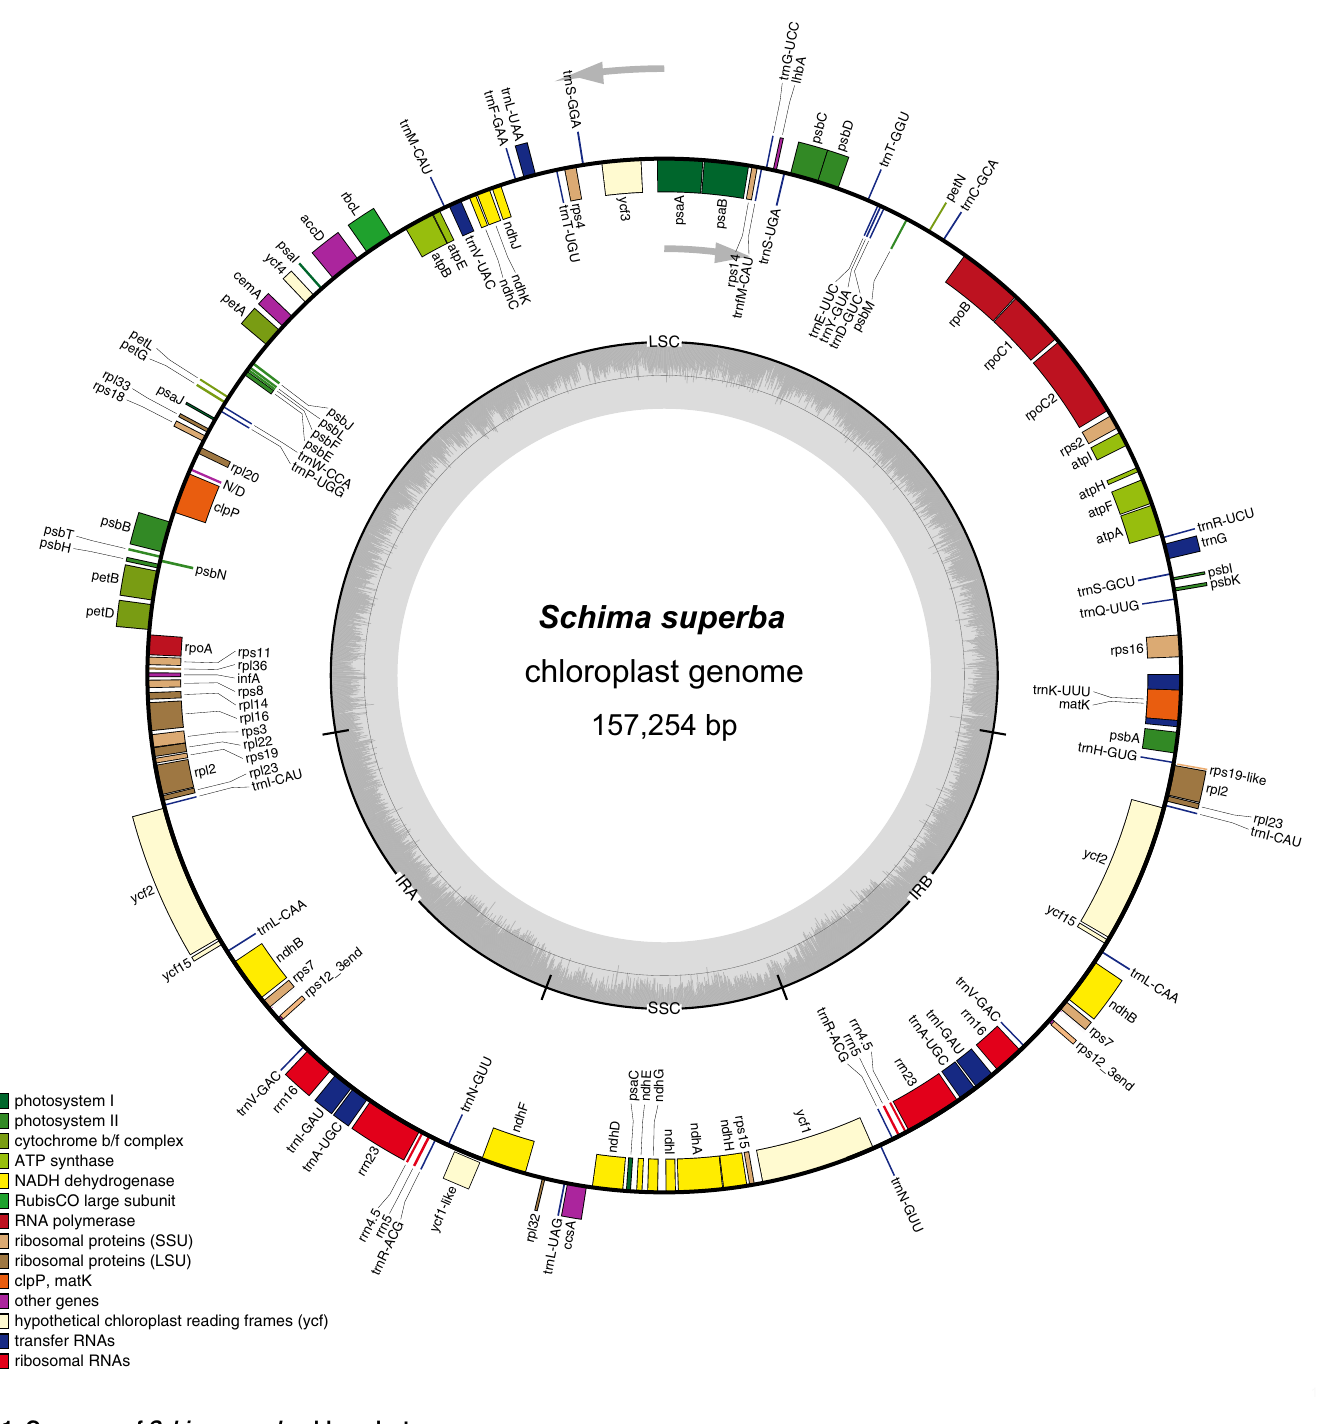
PLOS ONE | https://doi.org/10.1371/journal.pone.0178026 June 2,